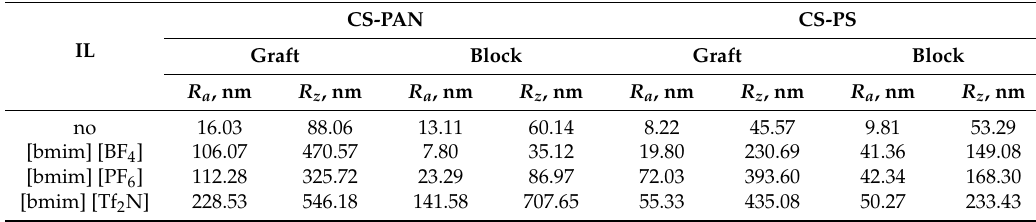
Table 1. The surface roughness